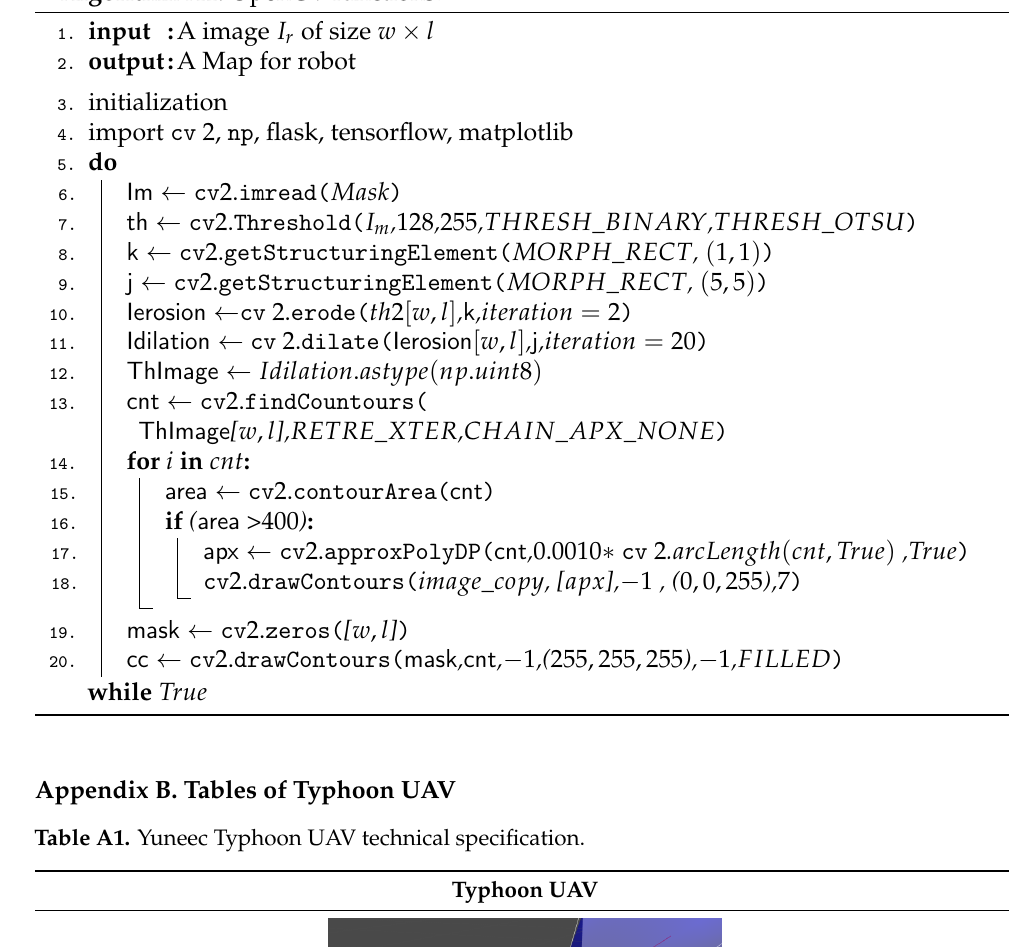
Algorithm A1: OpenCV functions.